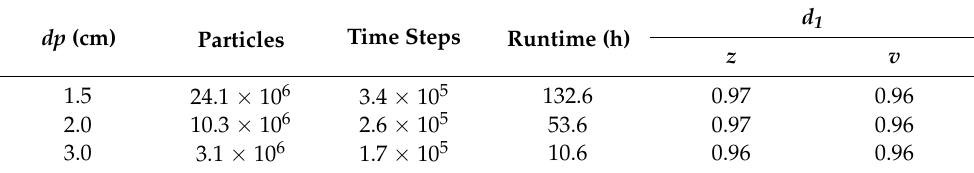
Table 2. Number of particles, number of total time steps, runtime and index of agreement for three values of dp .